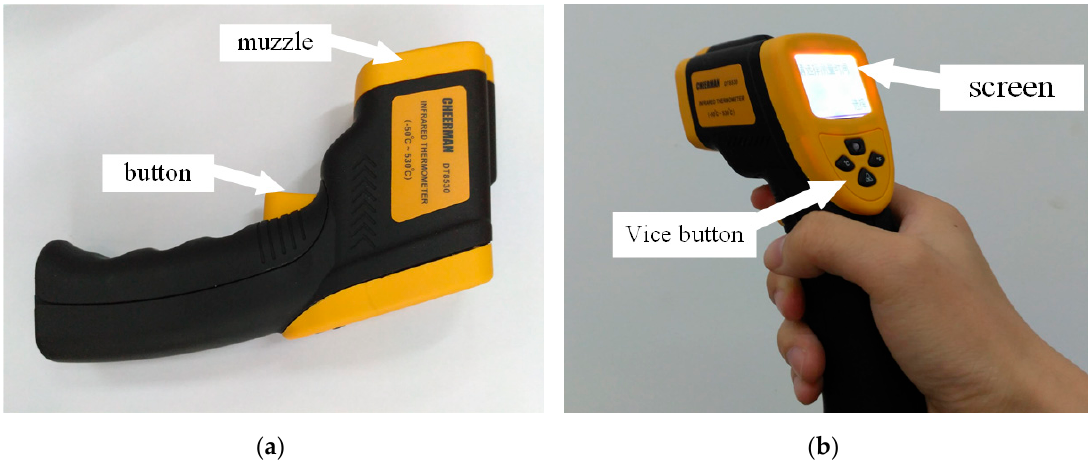
Figure 18. The PD detection device based on the UV Pulse Detection. ( a ) Main view. ( b ) Side view.